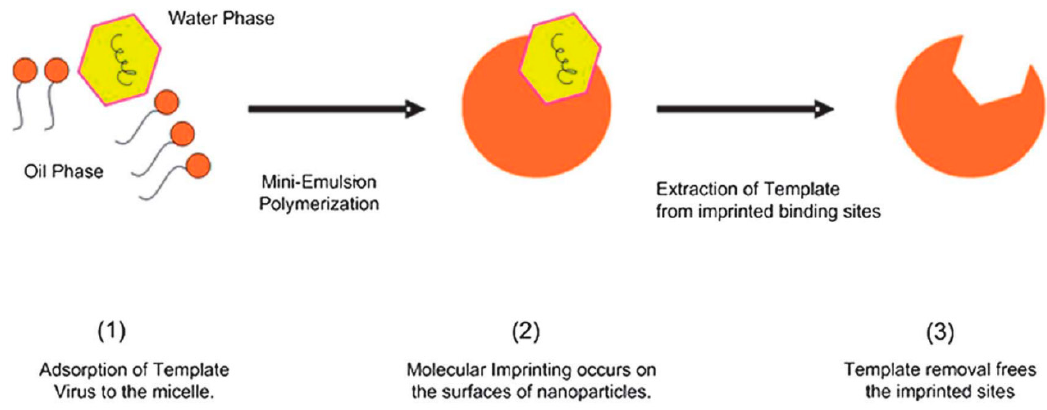
Figure 17. An illustration of virus surface imprinting via one-stage miniemulsion polymerization. Republished with permission of the Royal Society of Chemistry (RSC), from Sankarakumar N, Tong